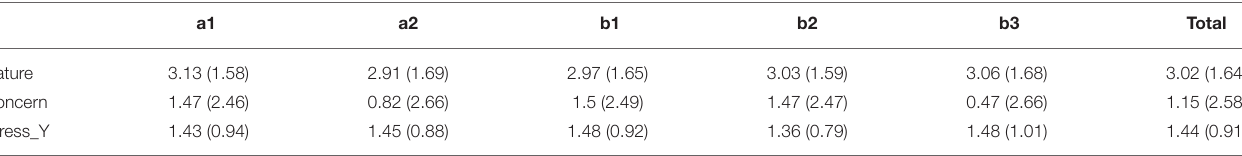
TABLE 5 | The young mean (SD) report in levels a and